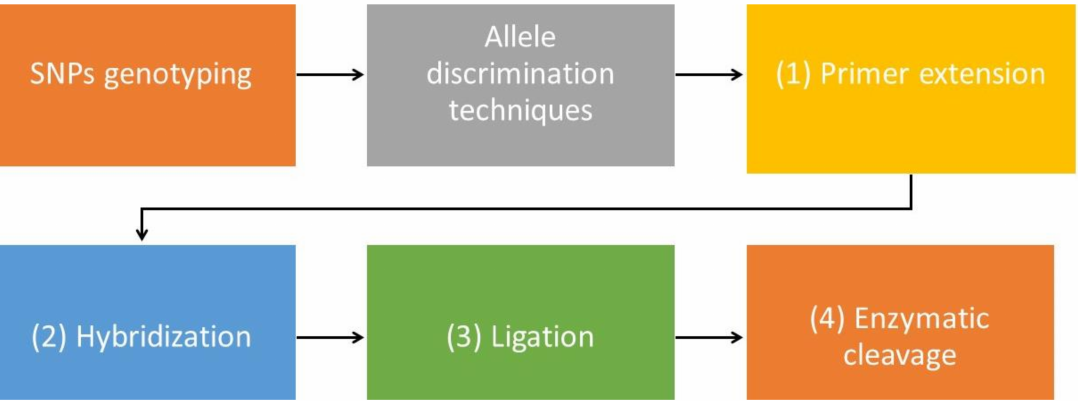
Figure 3. SNP genotyping in allele discrimination to increase the number of molecules for the detection of SNPs of interest in disease